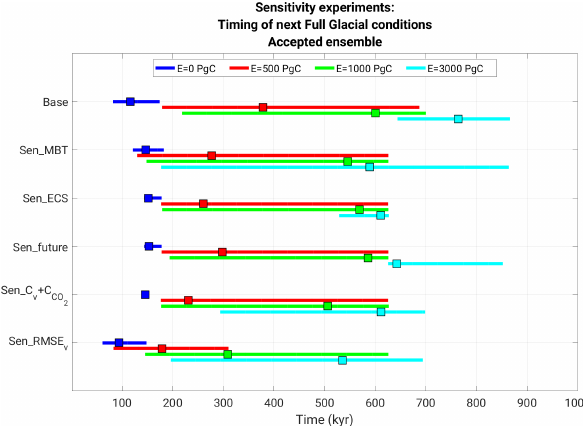
Figure 10. Timing of next full glacial conditions (first time af- ter present when v = 0 . 5) for different model configurations and emission scenarios, considering the Accepted solutions. For a cer- tain configuration and emission scenario, line segments indicate the 5%–95% percentiles of the timings, while squares indicate the en- semble